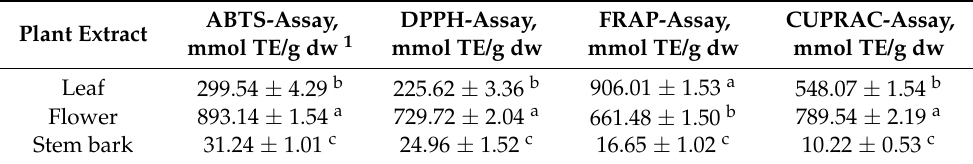
Table 2. In vitro antioxidant activities of ethanolic extracts from Ailanthus altissima aerial plant substances. Plant Extract